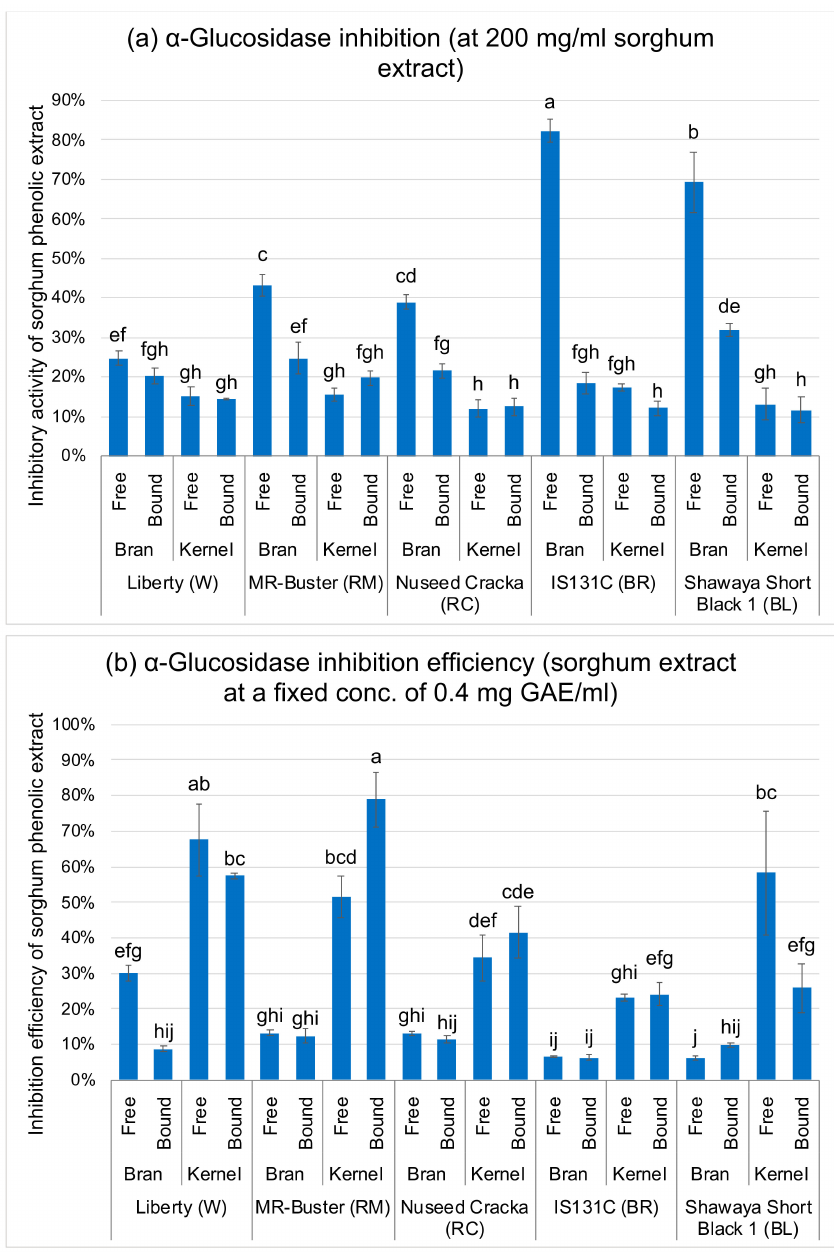
Figure 2. α -Glucosidase inhibitory activity ( a ) and the inhibition e ffi ciency ( b ) of sorghum phenolic extracts. Inhibition e ffi ciency is the inhibitory activity of phenolic extract at a fixed phenolic concentration, equals to the inhibitory activity of each extract sample divided by its total phenolic content. Error bars indicate ± standard deviation ( n = 3). Bars with di ff erent small letters are significantly di ff erent ( p <